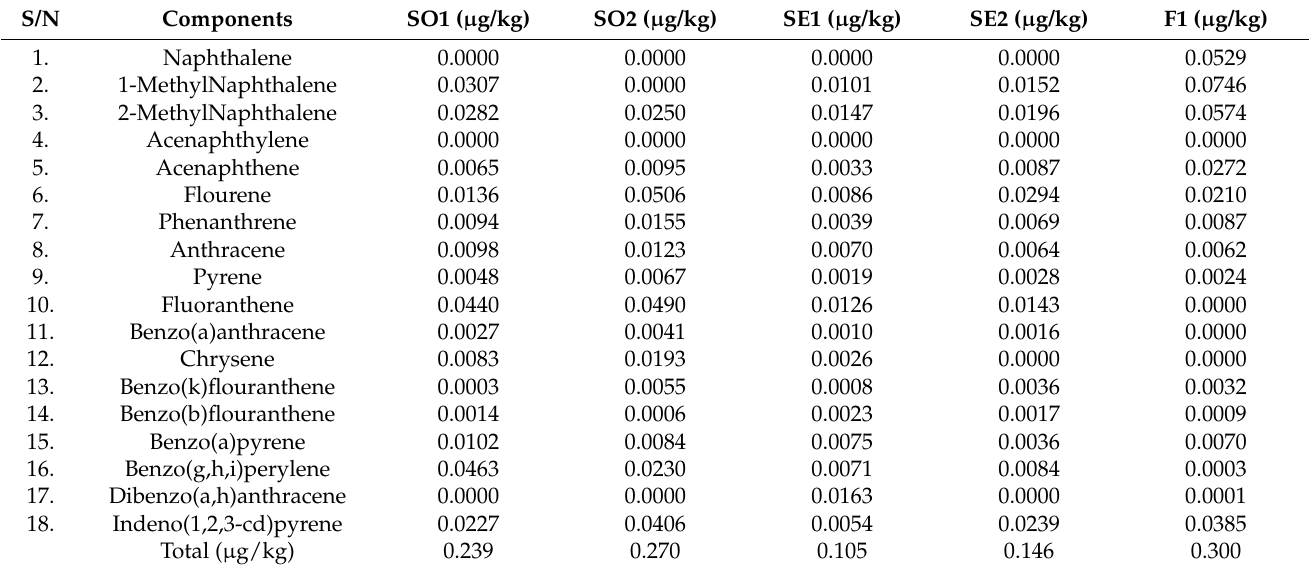
Table A1. Result of polycyclic aromatic hydrocarbons (PAHs) of soil, sediment, and fish